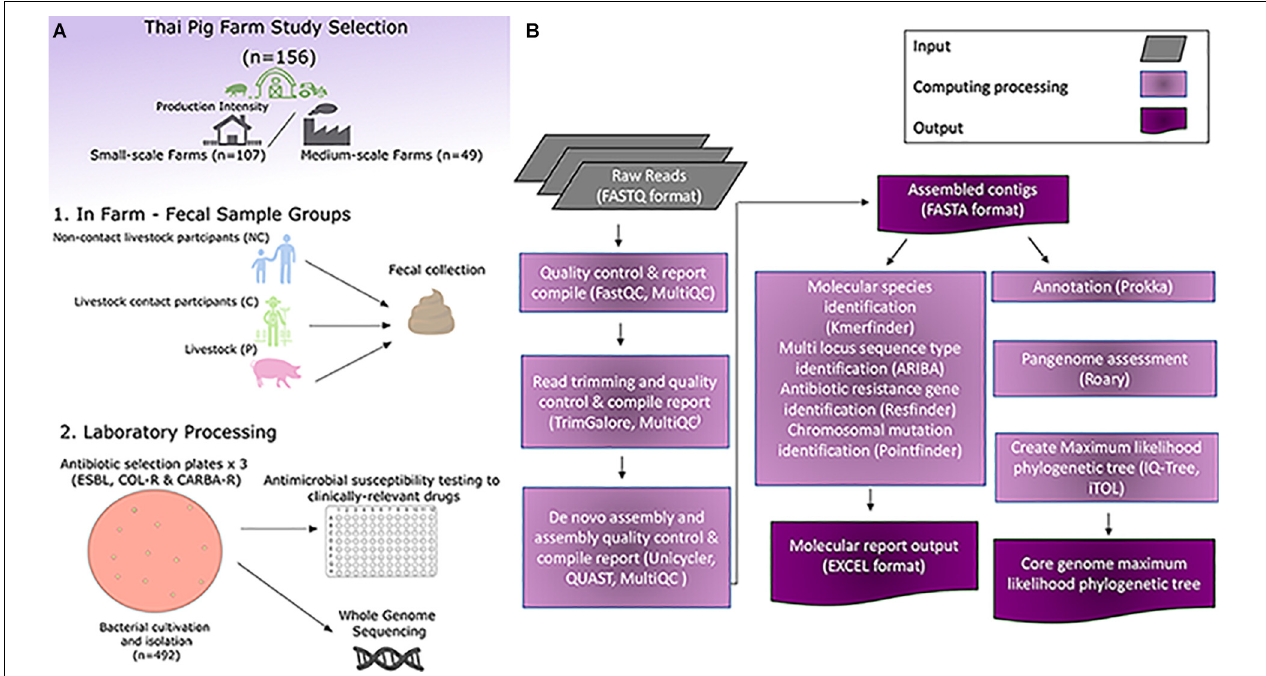
FIGURE 1 | Overview of experimental and computational set-up of the study. (A) Experimental workflow of the study. (B) Computational analysis work-flow of the